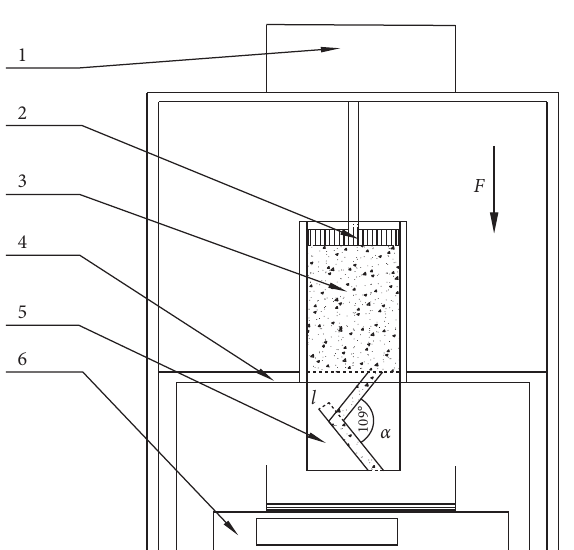
Figure 3: Fracture sand inrush test system. (1) Loading system; (2) piston; (3) sand grain; (4) test support; (5) fracture specimen; (6) data acquisition system.